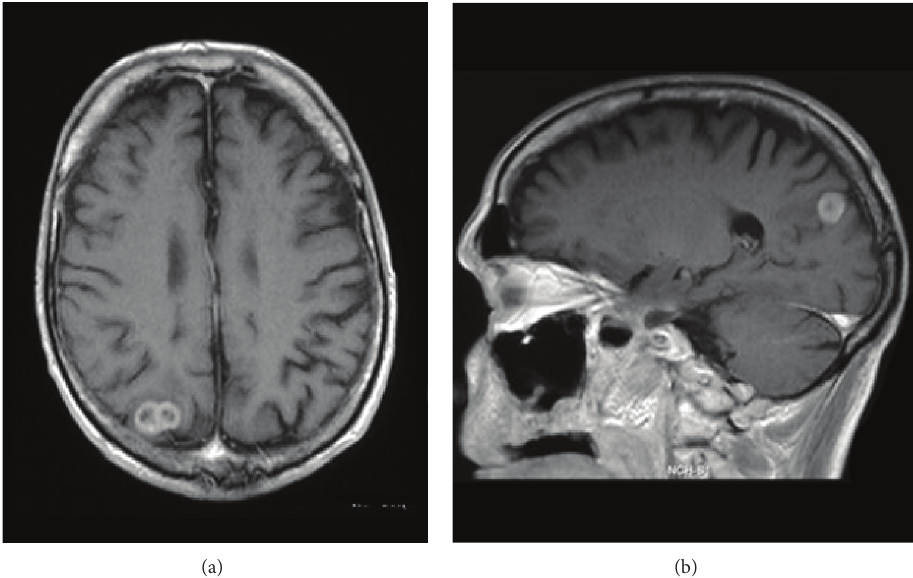
Figure 1: Axial (a) and sagittal (b) magnetic resonance scans (T1w with Gd) reveal an enhancing lesion with central necrosis in the right parietal lobe which is typically located in the cortical/subcortical layer.